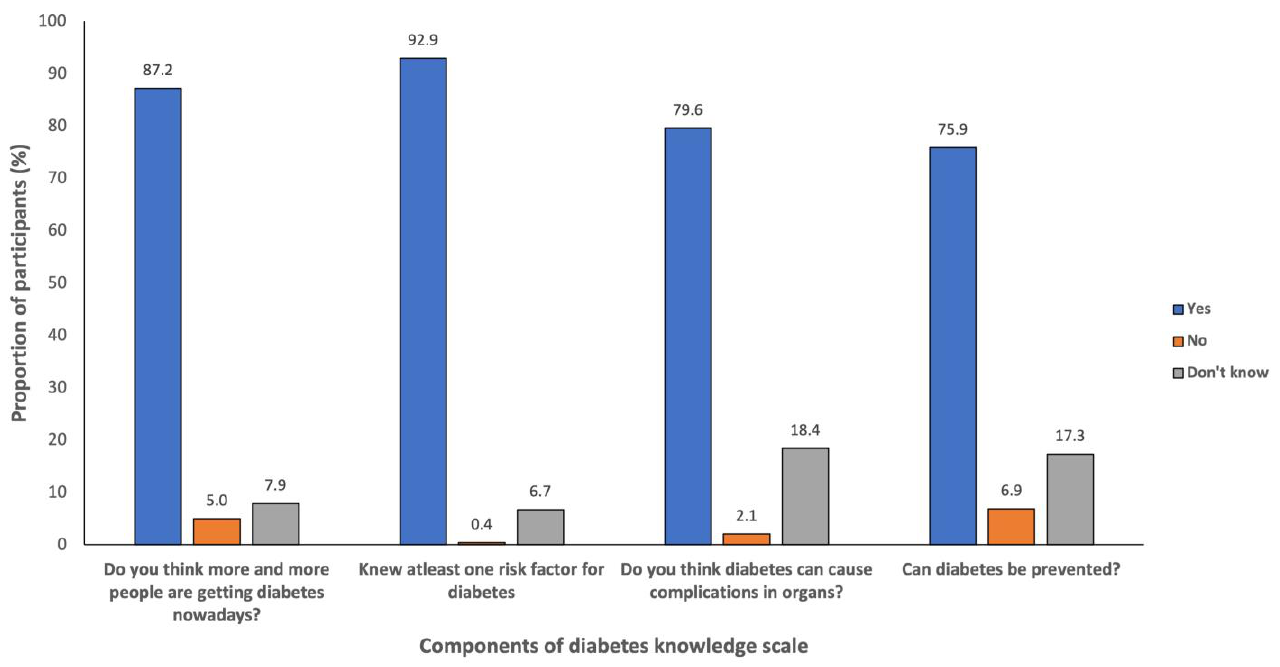
Figure 2. Components of diabetes knowledge scale among adults at high risk for type 2 diabetes.